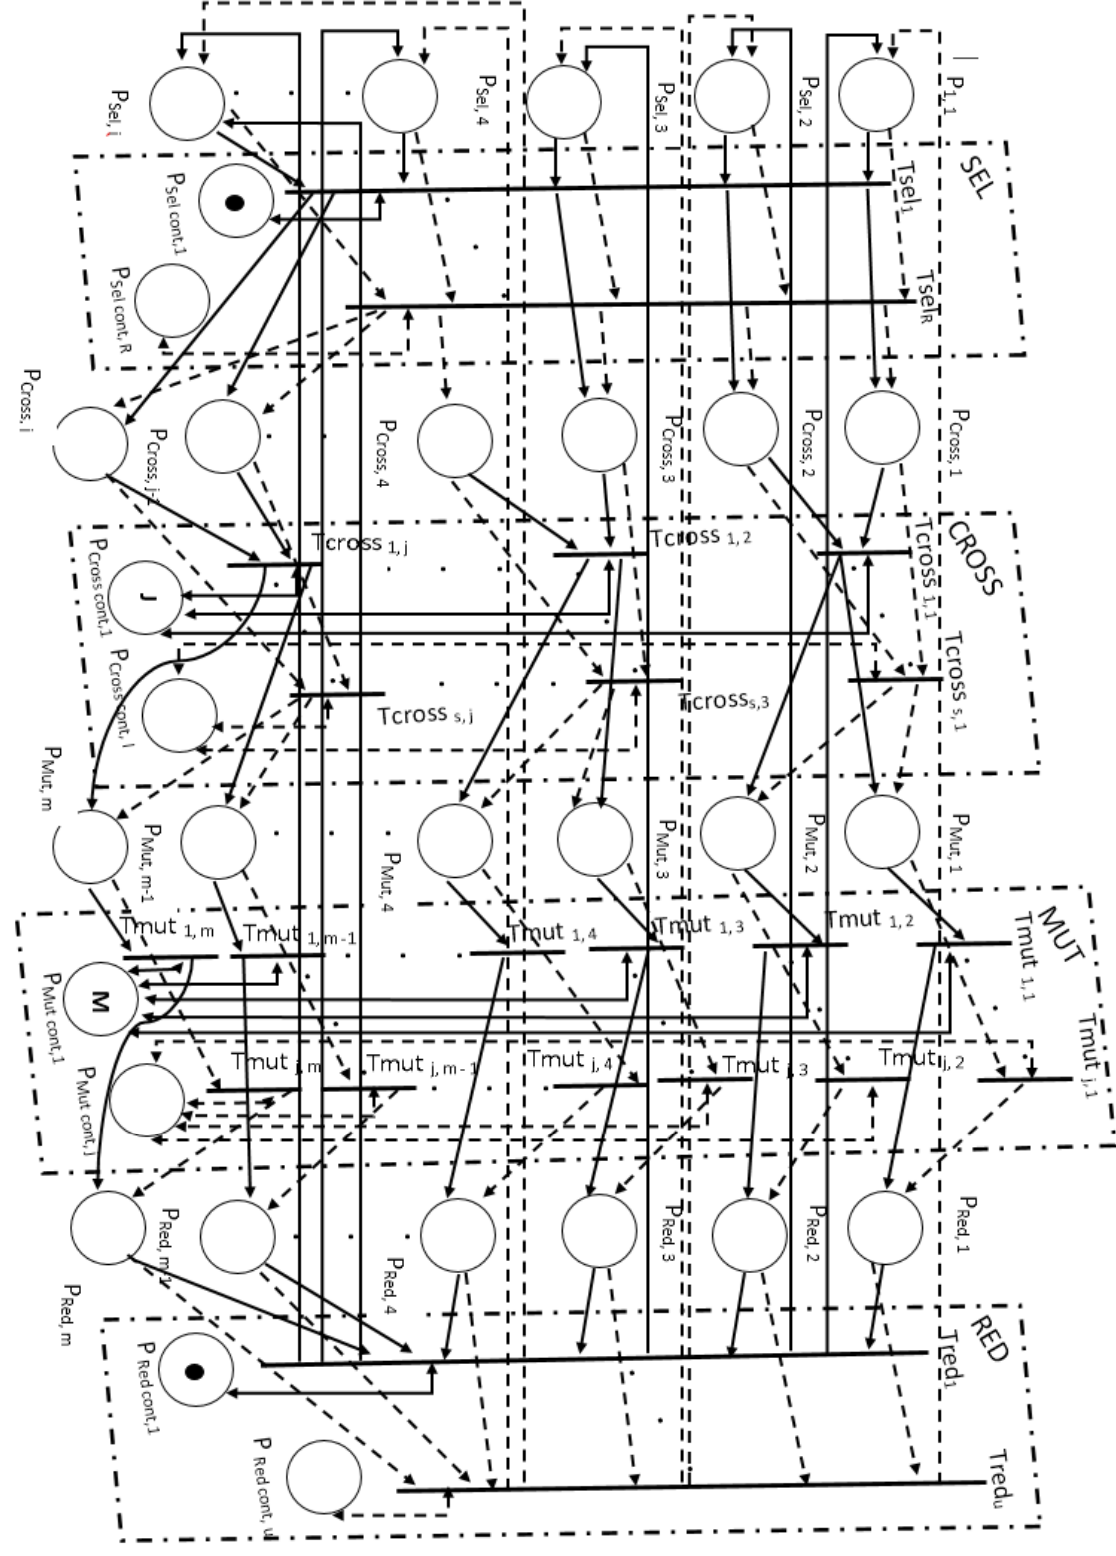
Figure 6. Adaptation of the genetic algorithm to the solution of the problem of structural–parametric synthesis and control of the search procedure using an artificial neural network model.